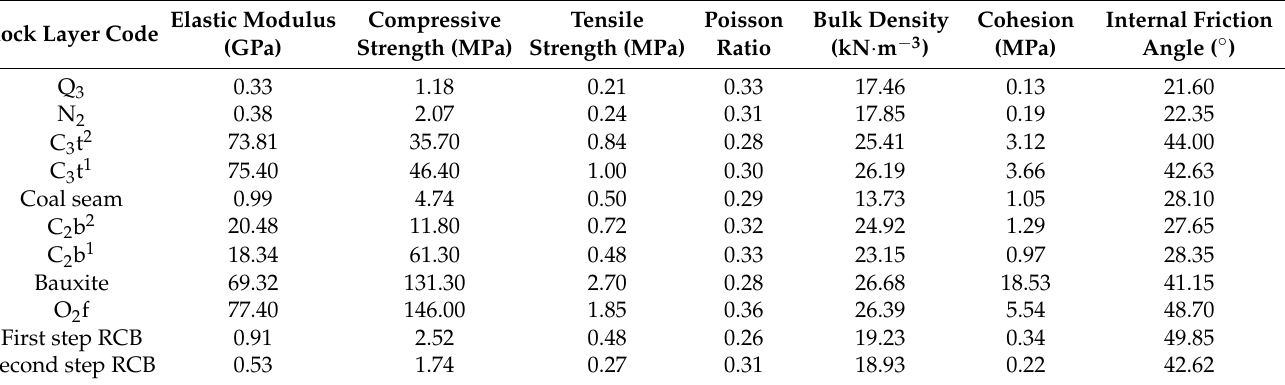
Table 3. Mechanical parameters of rocks and backfilling body.